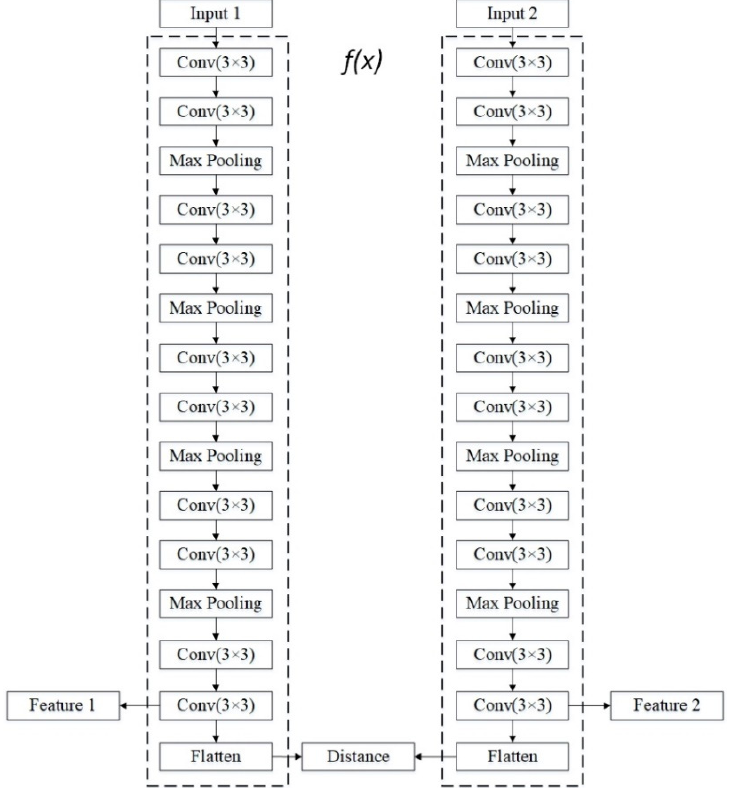
Figure 3. The proposed common information extraction structure. Two dotted boxes represent the information extraction path f ( x ), as mentioned in Equation (1). During the training process, the goal of the model is to minimize the output of the ‘Distance’ layer with the same scene multi-source inputs. The ‘Feature1’ and ‘Feature2’ layers are blocked during the model training process and is used for further parameter